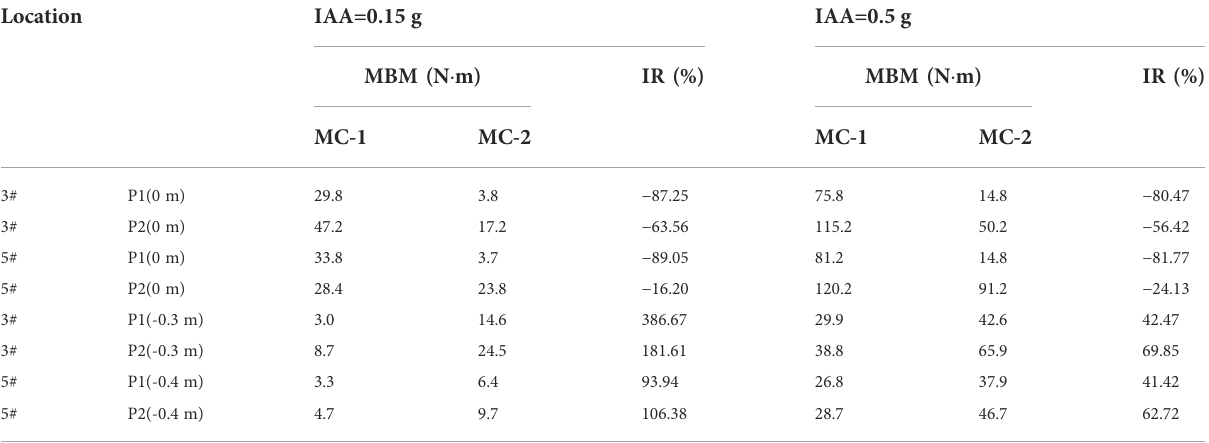
TABLE 4 Maximum bending moment and increase range with different moisture